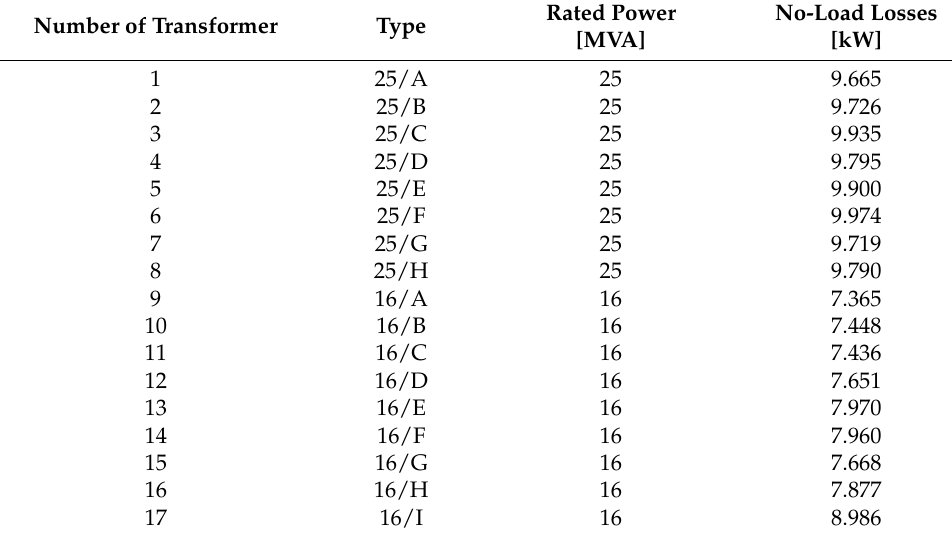
Table 4. List of tested transformers—units in use.